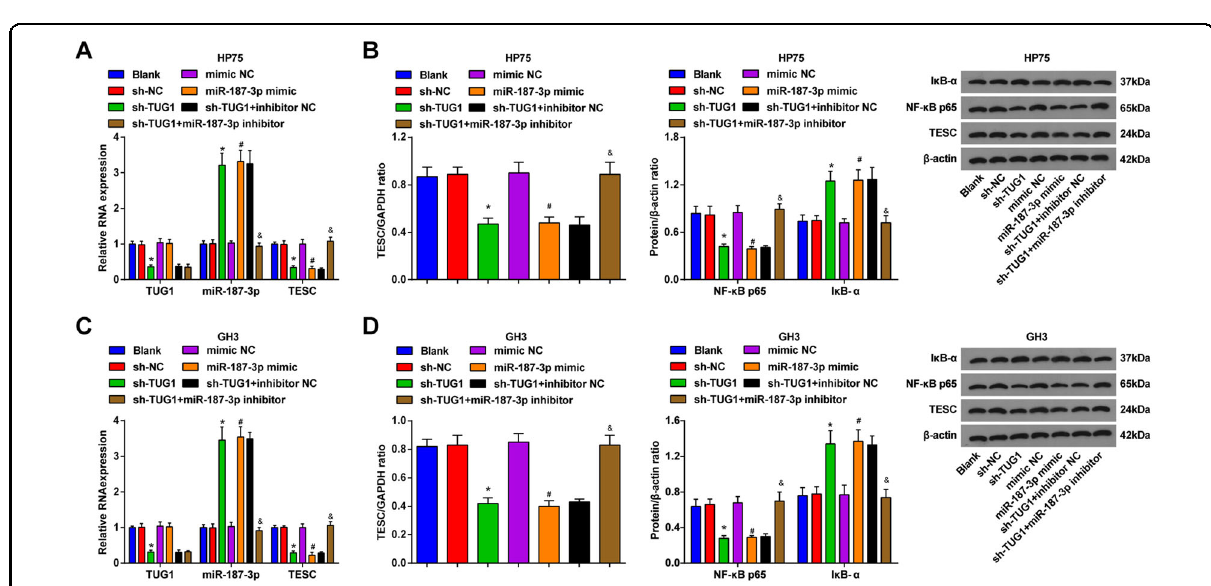
Fig. 6 TUG1 or miR-187-3p affects the NF- κ B signaling pathway. A expression levels of TUG1, miR-187-3p, and TESC in HP75 cells were assessed using RT-qPCR; B protein expression of TESC, NF- κ B p65, and I κ B- α in HP75 cells was assessed using western blot analysis; C expression levels of TUG1, miR-187-3p, and TESC in GH3 cells were determined using RT-qPCR; D protein expression of TESC, NF- κ B p65, and I κ B- α in GH3 cells was evaluated using western blot analysis; repetitions = 3. Data are presented as mean ± SD. * P < 0.05 vs the sh-NC group, # P < 0.05 vs the mimic NC group, & P < 0.05 vs the sh-TUG1 + inhibitor NC